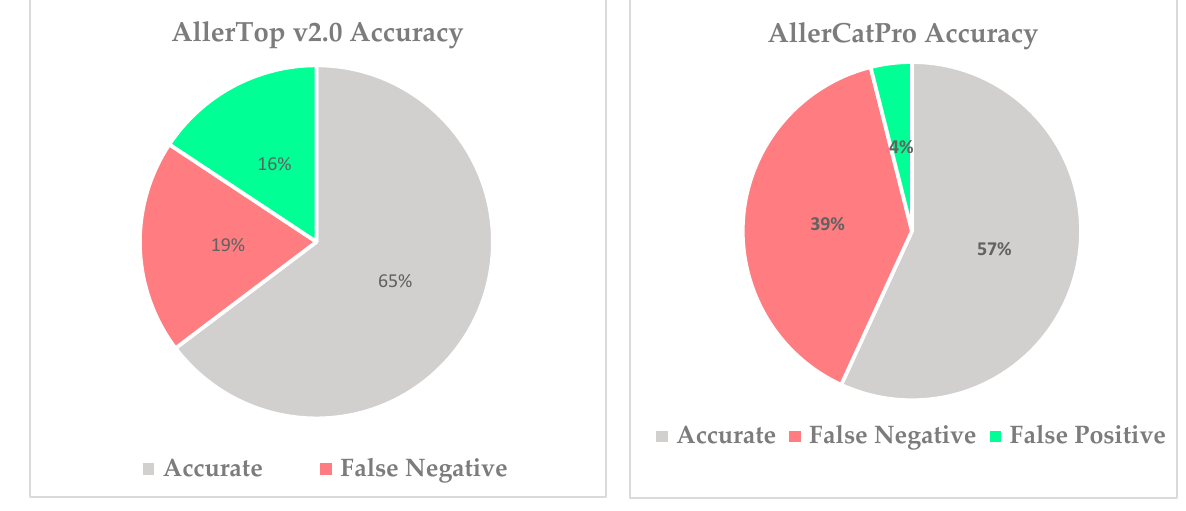
Figure 2. Comparison of allergenicity prediction tools using experimental allergenicity data from IEDB. ( a ) AllerTop v2.0 demonstrated superior sensitivity with a higher accuracy and higher false positive rate. ( b ) AllerCatPro demonstrated a greater rate of false negatives. AllerTop v2.0 was deemed the optimal allergenicity prediction tool for MHC class I epitope data prediction.